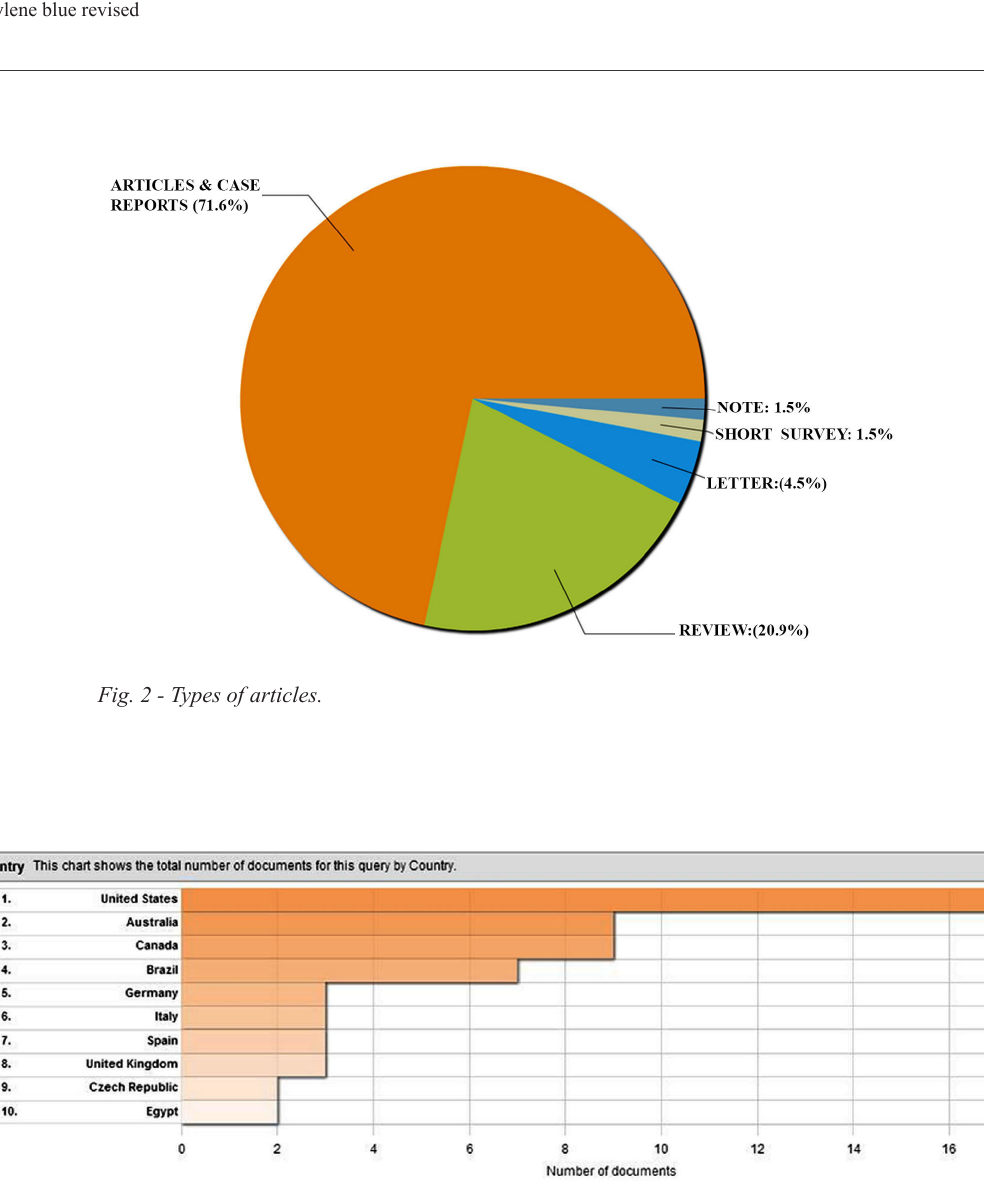
Fig. 3 - Country of origin of publications.